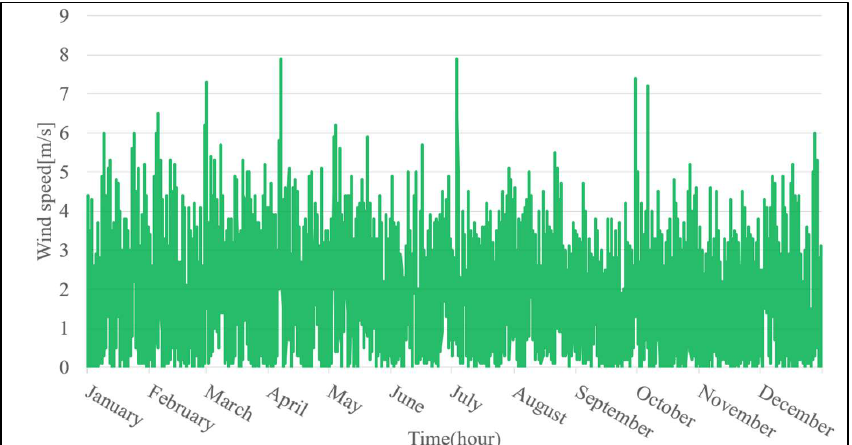
Figure 13. Hourly wind speed in Fukuoka (Source: JMA).